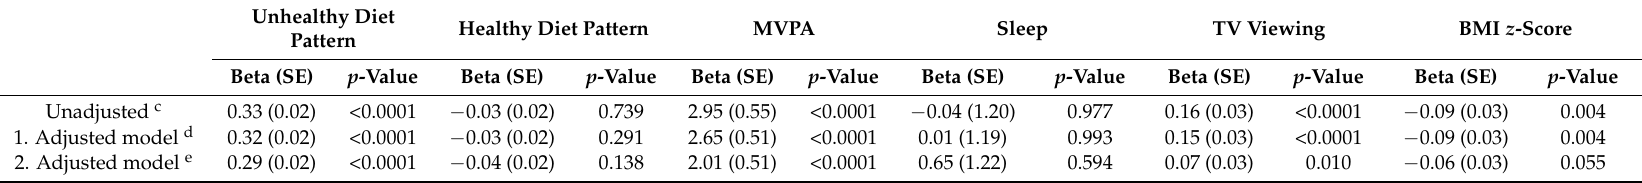
Table 3. The associations a between emotional eating factor scores (as the independent variable) and outcome variables b . n = 5426.